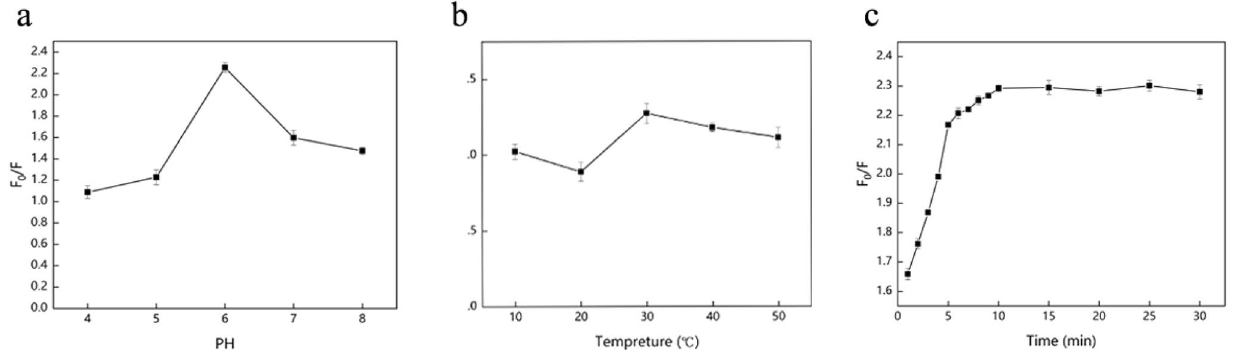
Figure 4. Influence of different environmental factors on the effect of Cu 2+ quenching CCYWDAHRDY- AuNCs Fluorescence: ( a ) Fluorescence-emission intensity of CCYWDAHRDY-AuNCs to Cu 2+ at different pH values, ( b ) Fluorescence-emission intensity of the CCYWDAHRDY-AuNCs to Cu 2+ at different temperatures, ( c ) Evolution of the intensity of the fluorescence emission of CCYWDAHRDY-AuNCs to Cu 2+ over time.